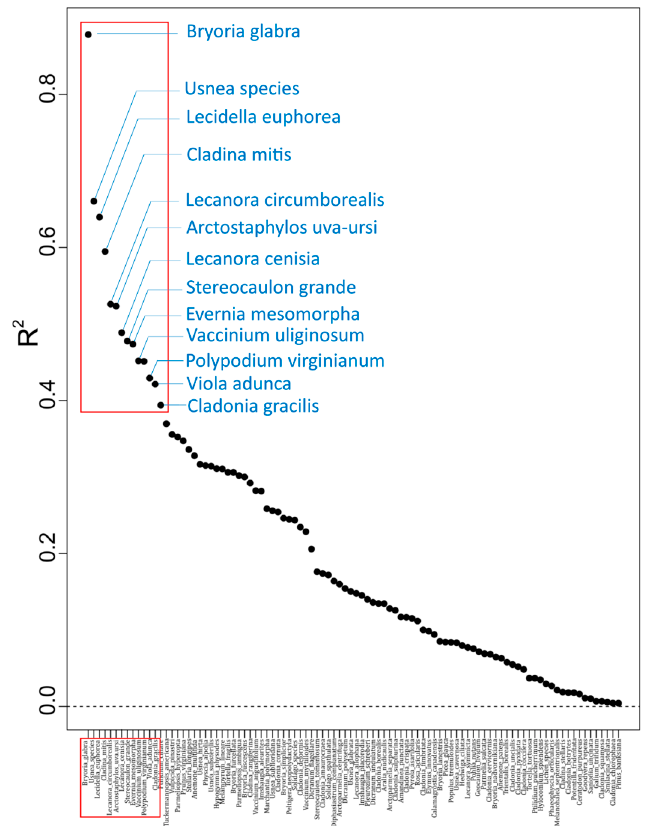
Figure 2. Species R 2 overall performance, a measure of the fit of random forest model for each species, with all 96 species with positive R 2 values labelled on the X axis. The red outline identifies 13 species that were particularly well predicted by the environmental variables (R 2 > 0.4). Species with zero or negative R 2 overall performance values are not included. Table 3. R 2 overall importance, the sum of R 2S performance values for all environmental variables across a given species, for top 13 species (R 2 > 0.4). Specific R 2 performance values (R 2S ) for the top five environmental variables associated to each species.